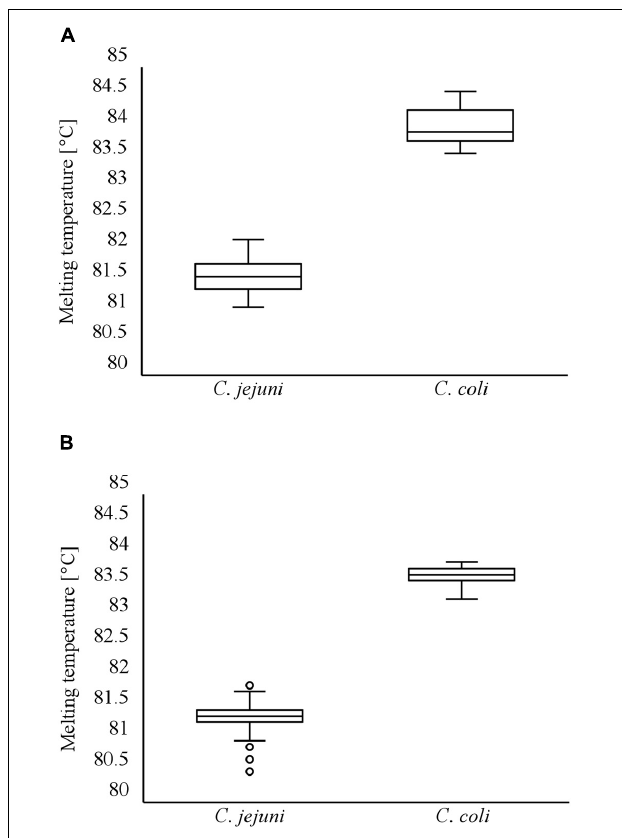
FIGURE 4 | Distribution of melting temperatures of LAMP products during investigation of artificially contaminated minced meat using cdtC – gyrA LAMP (A) . Distribution of melting temperatures of LAMP products during investigation of naturally contaminated meat samples using cdtC – gyrA LAMP (B) .